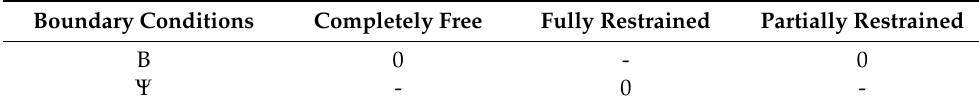
Table 1. Boundary conditions (B and Ψ ) for warping. Boundary